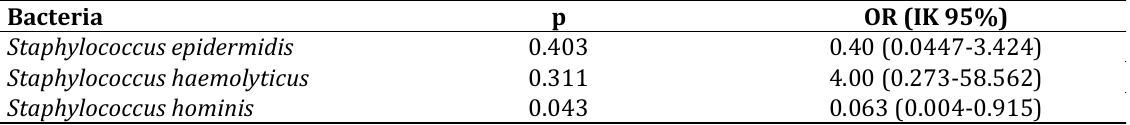
Table III. Logistic regression of DDD versus percentage of antibiotic resistance